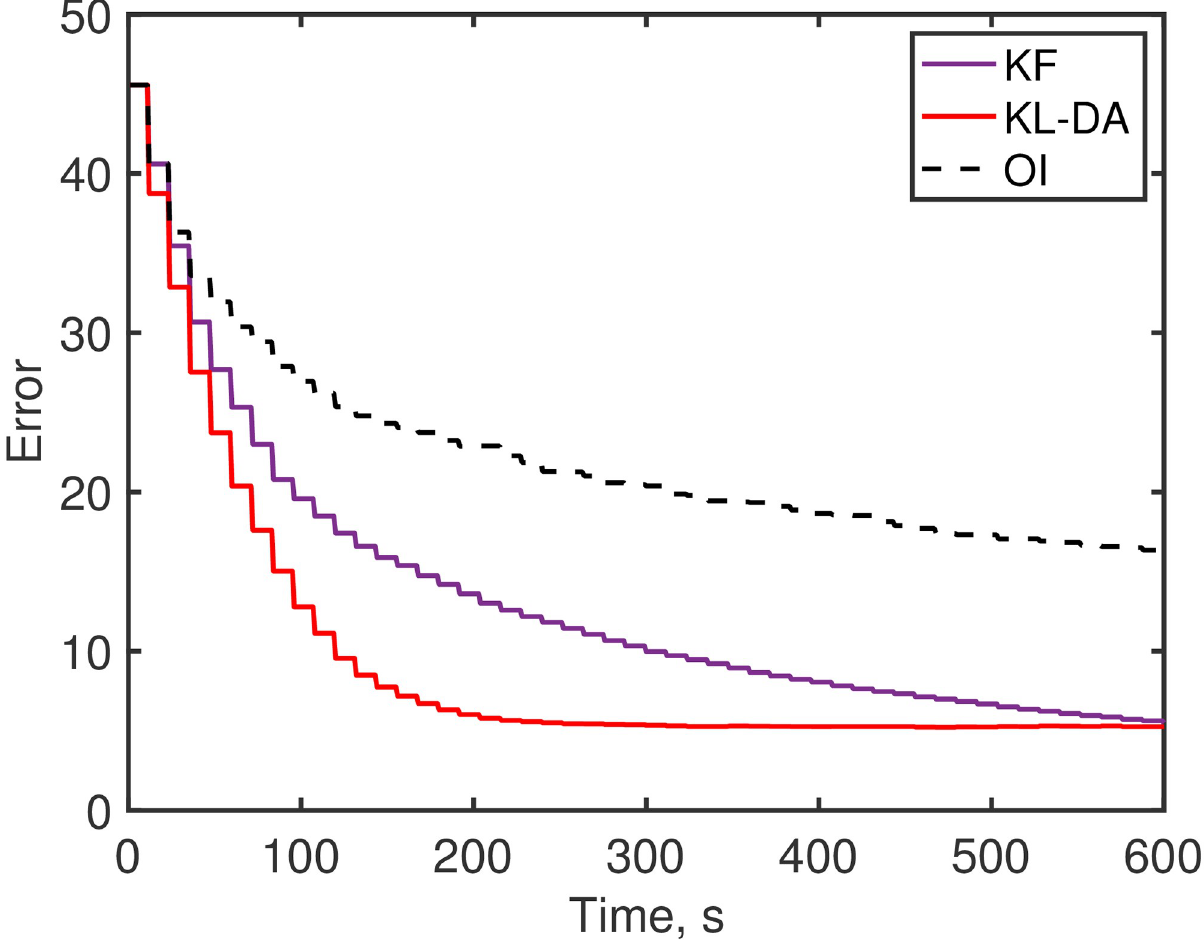
Fig 6. Experiment 3 error. The error, jj w t (cid:0) w jj 2 , growth over time using the Kalman filter (purple), the Kullback-Leibler data assimilation (red), and 2 the OI (black dashes) solutions. The error curves are determined based on the mean of 100 simulations.